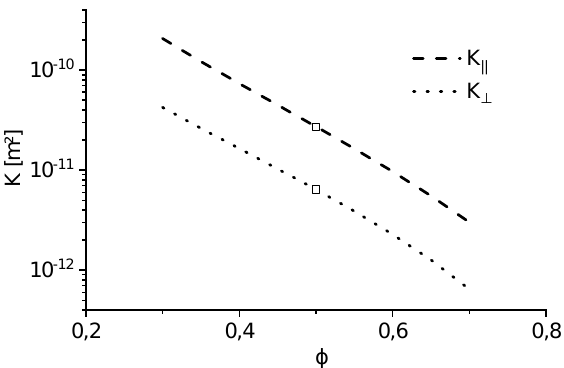
Figure 3. Permeability after Gebart, using the measured values K (cid:107) , exp = 2.72 × 10 − 11 m 2 and K ⊥ , exp = 6.40 × 10 − 12 m 2 at ϕ exp =